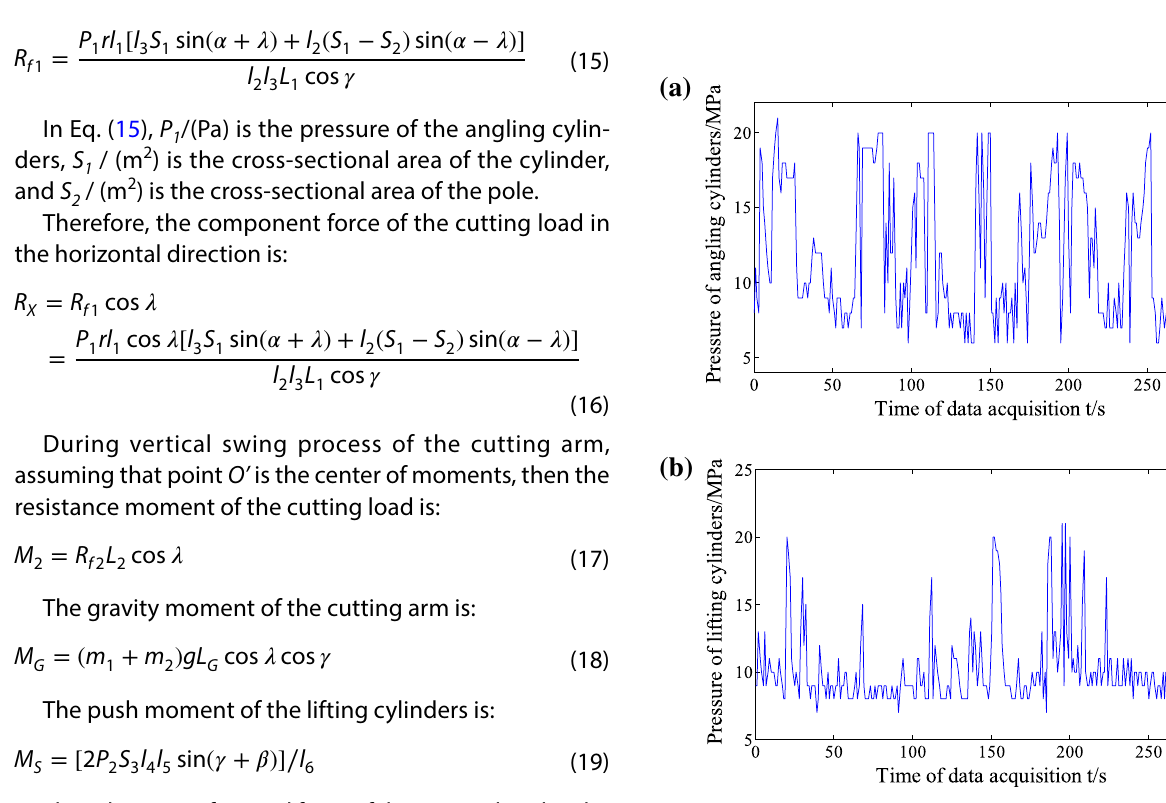
Fig. 6 Pressure of the driving cylinders measured in field. ( a ) Pres- sure of angling cylinders; ( b ) Pressure of lifting